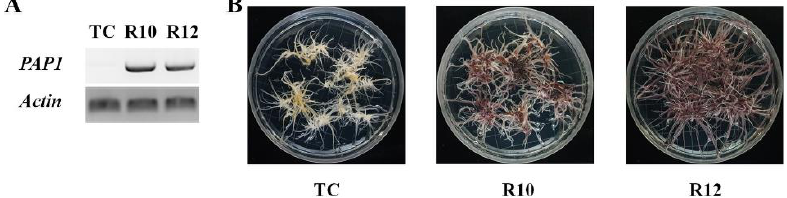
Figure 1. Identification and characterization of PAP1 -overexpressing transgenic lines. ( A ) PAP1 expression in transgenic ginseng hairy roots was confirmed via RT-PCR. ( B ) Phenotyping of PAP1 -overexpressing ginseng hairy roots. Two transgenic lines (R10 and R12) and a transgenic control (TC) were selected for further studies.